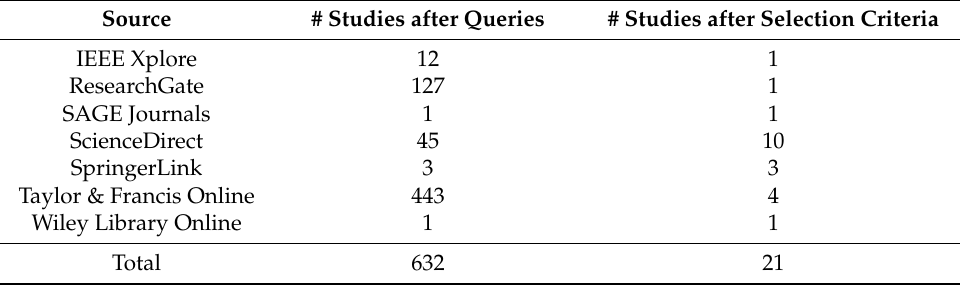
Table 1. Overview of the search results and study